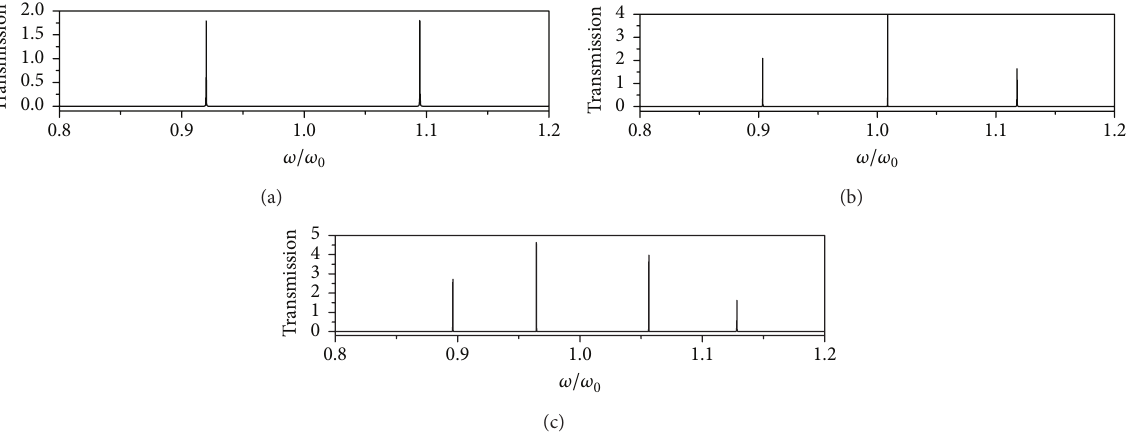
Figure 6: The quantum transmissivity for QW structure (𝐵𝐴) 6 (𝐵𝐵𝐴𝐵𝐵) 𝑛 (𝐴𝐵) 6 with 𝑛 𝑏 = 2 . 45 − 𝑖 0 . 0001. (a) 𝑛 = 1, (b) 𝑛 = 2, and (c) 𝑛 = 3.